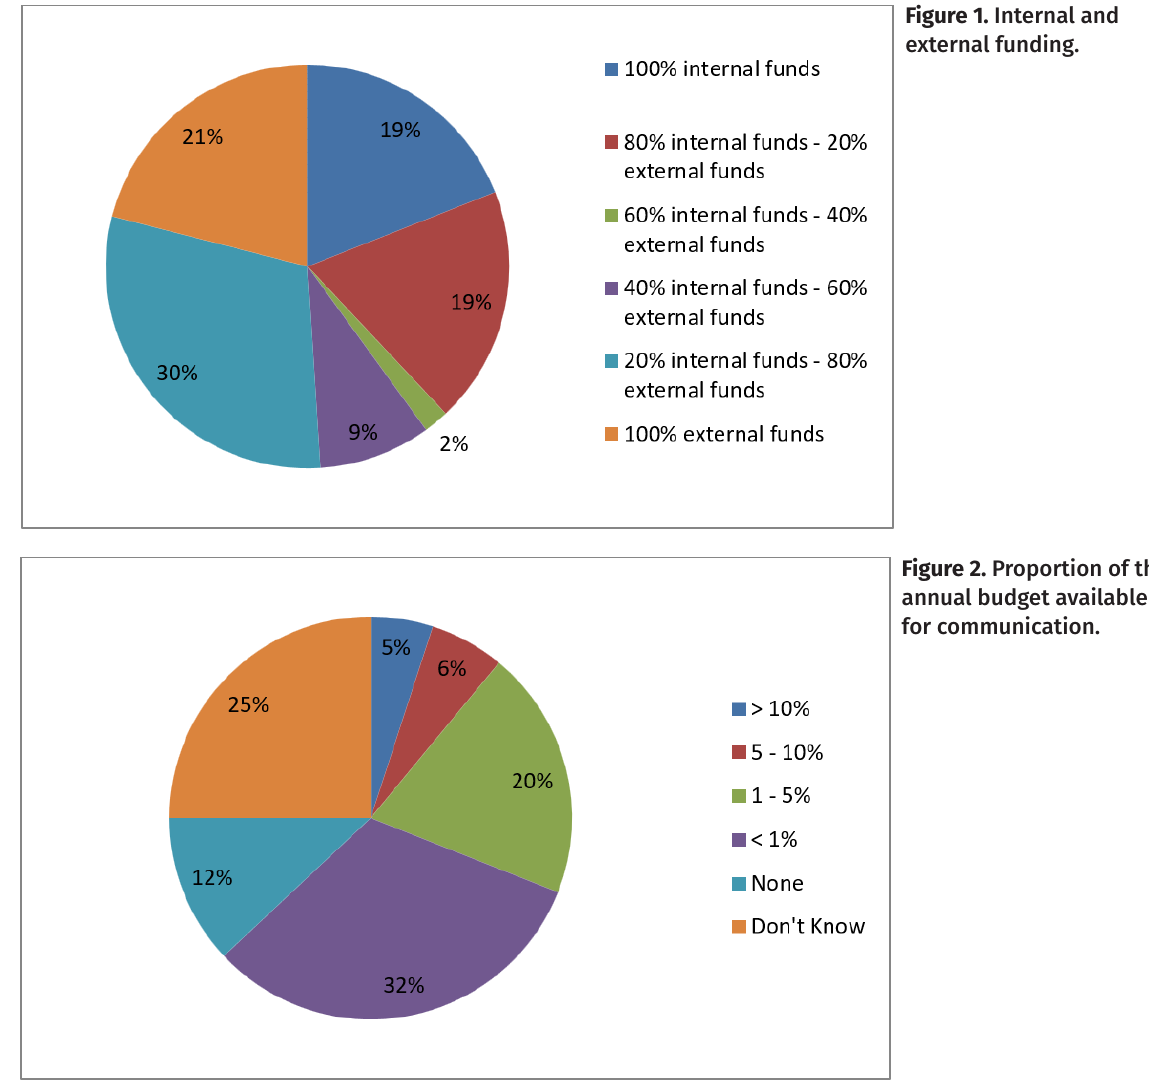
Figure 2. Proportion of the annual budget available for communication.